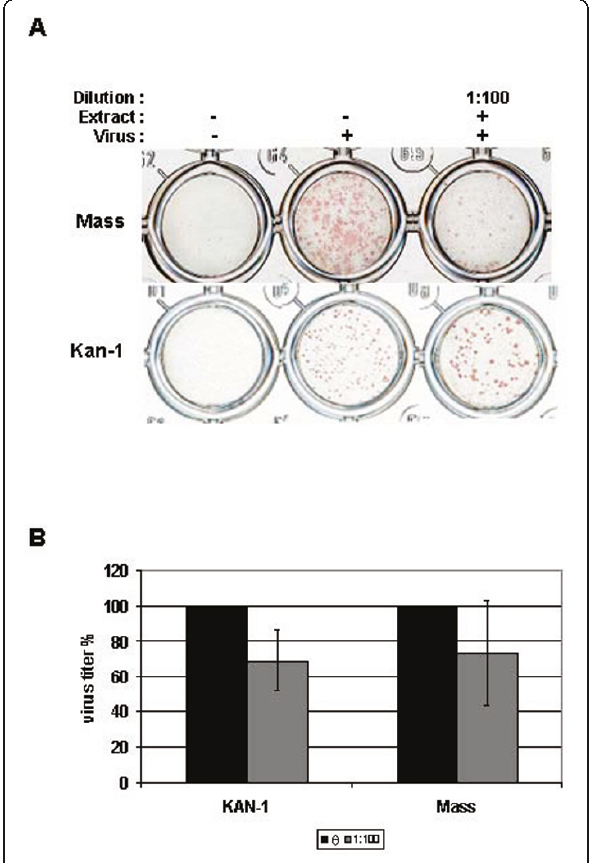
Figure 2 Impact of the elderberry extract on propagation of IV . A) Focus size reduction assay. MDCK cells were infected with the two virus strains as indicated and incubated for 48 h in the presence of the extract (1:100). Foci were detected by immunochemistry. B) Pre-treated MDCK cells were infected with pre-treated virus and were propagated for 48 h in the presence of the extract. As control untreated virus and cells were used for infection. The mean titre of three independent experiments is given as percentage of the control (black) set to 100%. Standard deviation is indicated (KAN-1: p < 0.07, Mass: p <